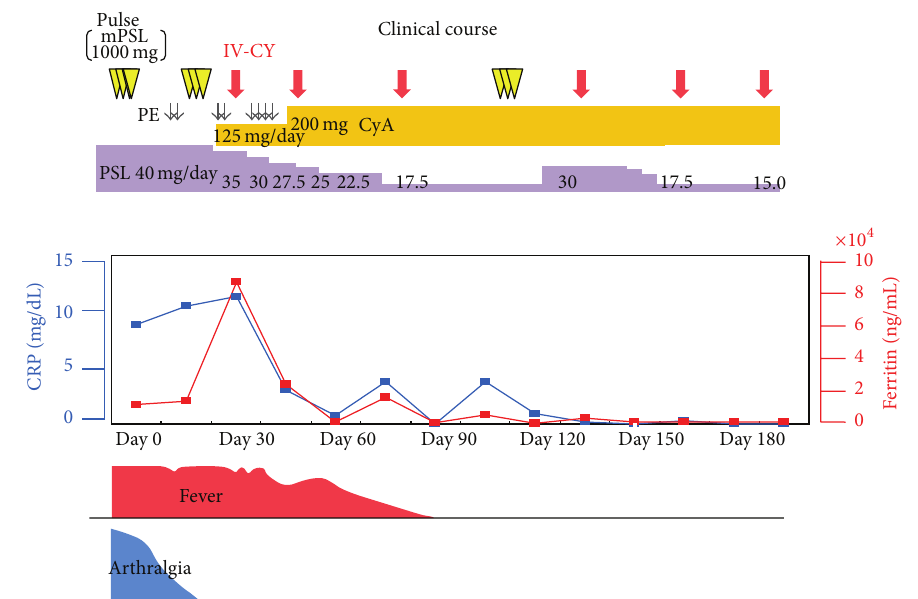
Figure 1: Clinical course. CyA: cyclosporine A; IV-CY: intravenous cyclophosphamide; mPSL: methylprednisolone; PE: plasma exchange.